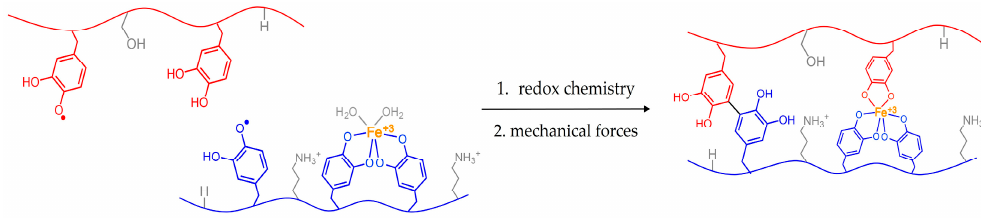
Figure 2. Possible scenario depicting how reactive species within a solid could be brought closer together via mechanical forces. Tugging from byssal retractor mussels could better align reactive groups for adhesive curing.